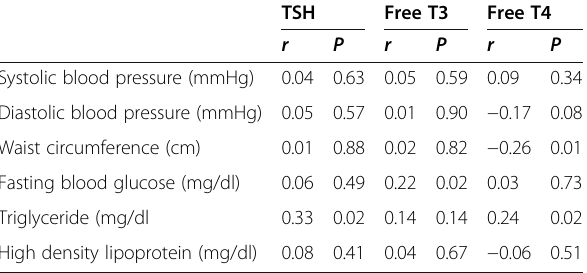
Table 4 Status of thyroid function among enrolled groups MetS group (n= 100)